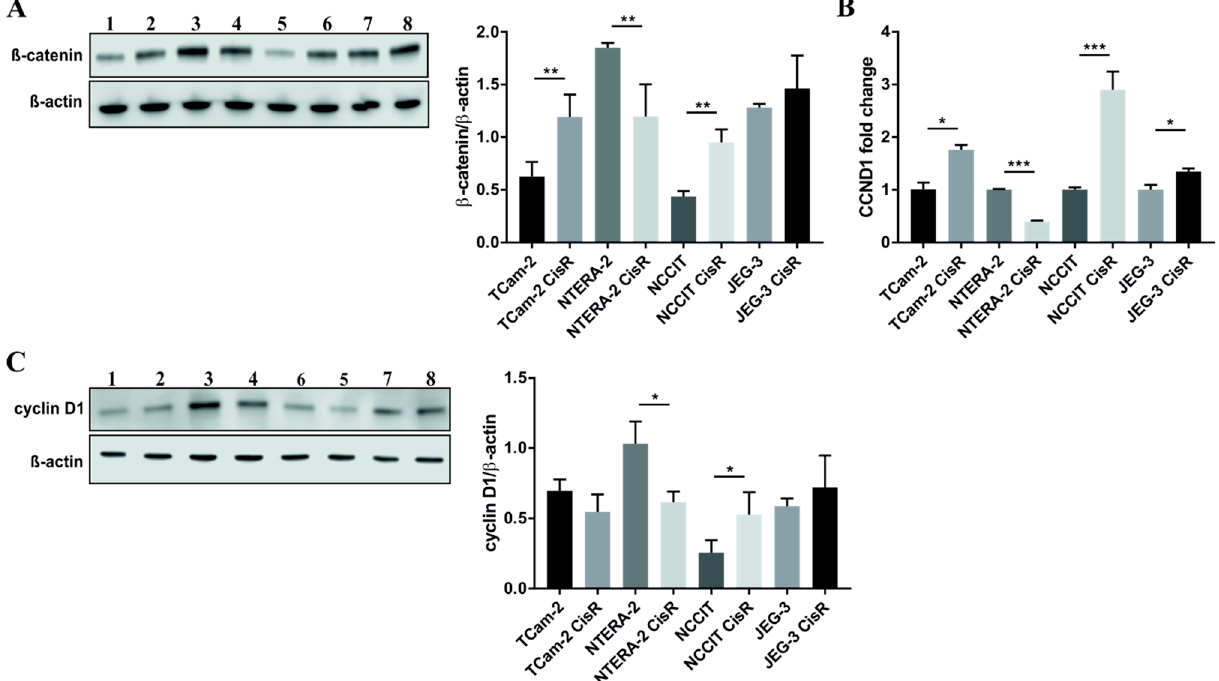
Figure 2. NTERA-2 CisR cells exhibited decreased levels of β -catenin and cyclin D1 compared to parental cells. ( A ) The western blot analysis of β -catenin showed decreased level of this protein in NTERA-2 CisR cells. Other GCT cell lines had increased expression of β -catenin on the protein level what was confirmed also by densitometric analysis. ( B ) Only chemoresistant NTERA-2 CisR cells exhibited the decrease in CCND1 expression as demonstrated by qPCR. ( C ) Western blot and densitometric analysis confirmed significantly decreased expression of cyclin D1 also on the protein level. 1. TCam-2; 2. TCam-2 CisR; 3. NTERA-2; 4. NTERA-2 CisR; 5. NCCIT; 6. NCCIT CisR; 7. JEG-3; 8. JEG-3 CisR. β -actin was used as an internal loading control. * p < 0.05, ** p < 0.01, *** p < 0.001.